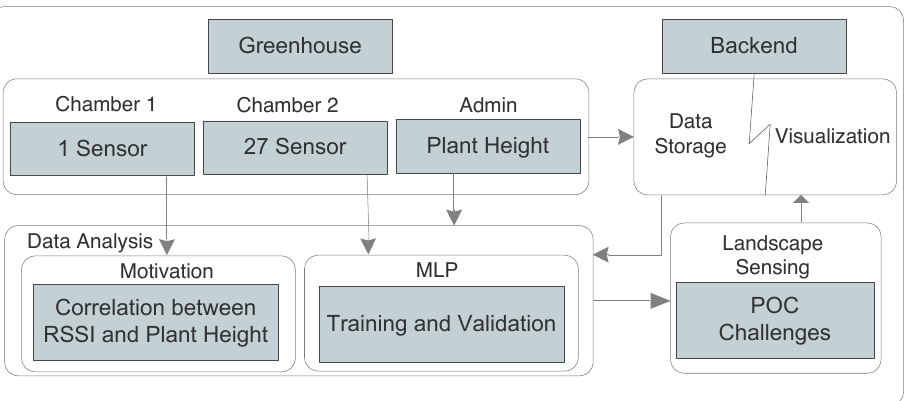
Figure 1. Figure illustrating the flow of experiments and data interaction to derive landscape sensing in the greenhouse. Data from chamber 1 is taken to set up the hypothesis, and chamber 2 data along with manual plant height data recorded from the admin in greenhouse is used for